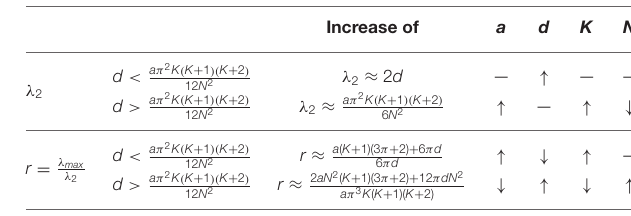
TABLE 1 | Change of a , d , K , N for λ 2 , r = λ max /λ 2 of two-layer K-nearest-neighbor networks.